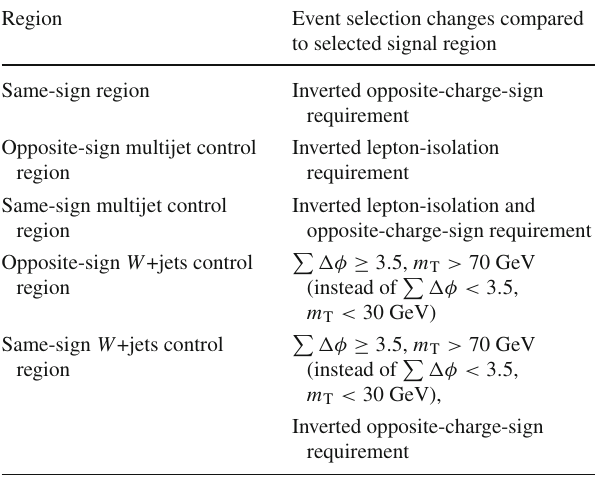
Table 3 Summary of the control regions used for the background esti- mates Region Event selection changes compared to selected signal region Same-sign